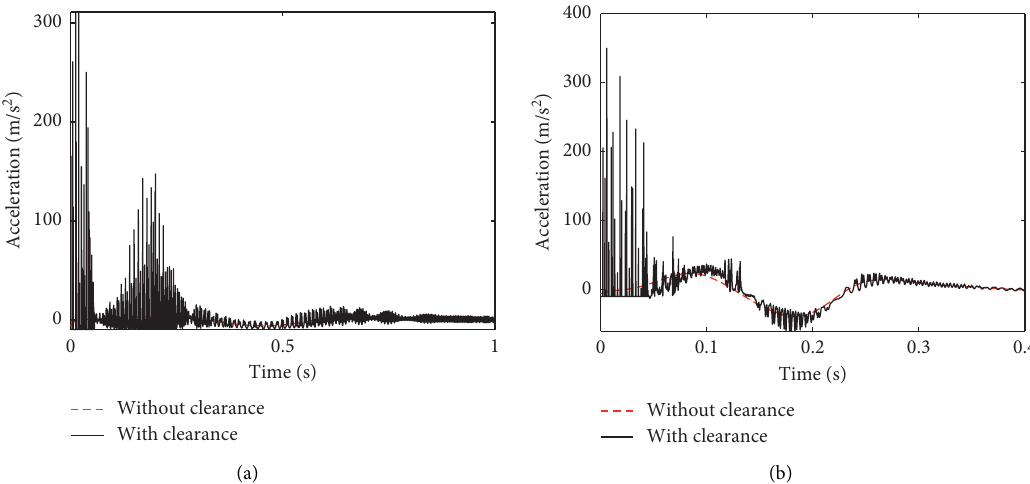
Figure 21: Acceleration of the slider. (a) ω